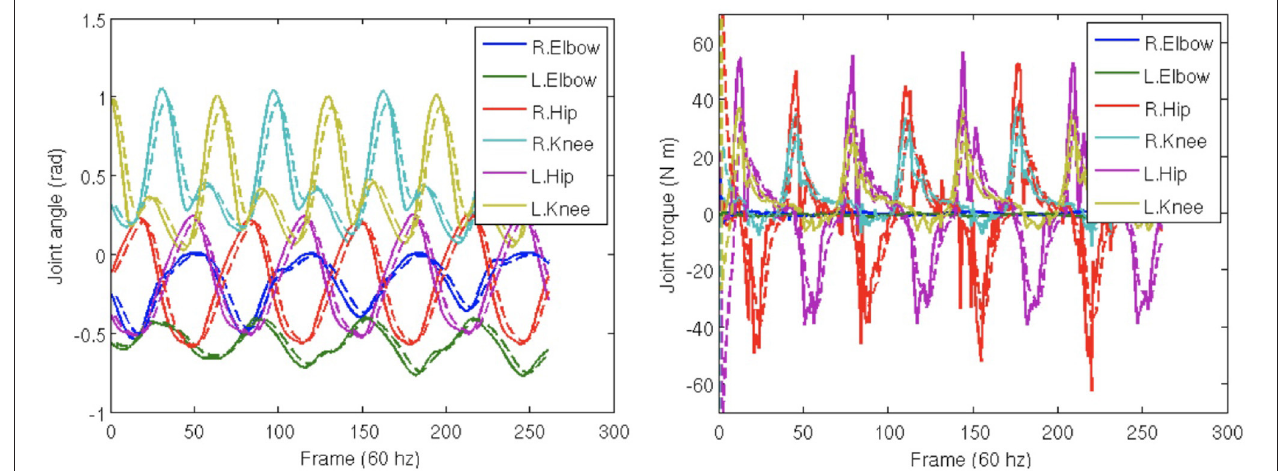
FIGURE 7 | Trajectory reconstruction. Trajectories of selected degrees of freedom from the perturbation study. Solid lines show ground truth calculated from the motion capture data. Dashed lines show recovered data. Simulated spring forces make the computed data lag behind and smooth the ground truth.